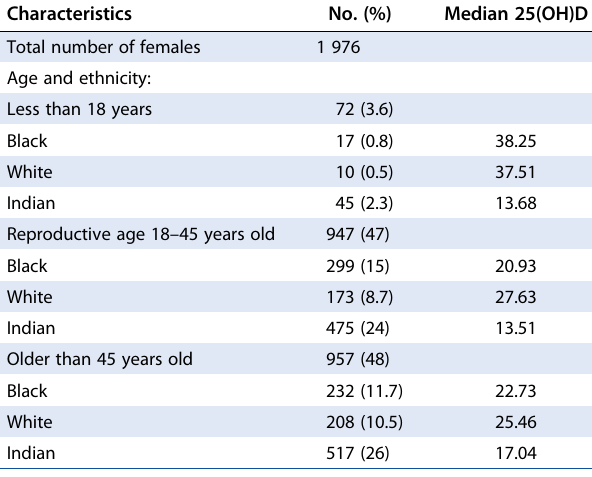
Table 1: Age category, ethnicity of study population and median 25 (OH)D